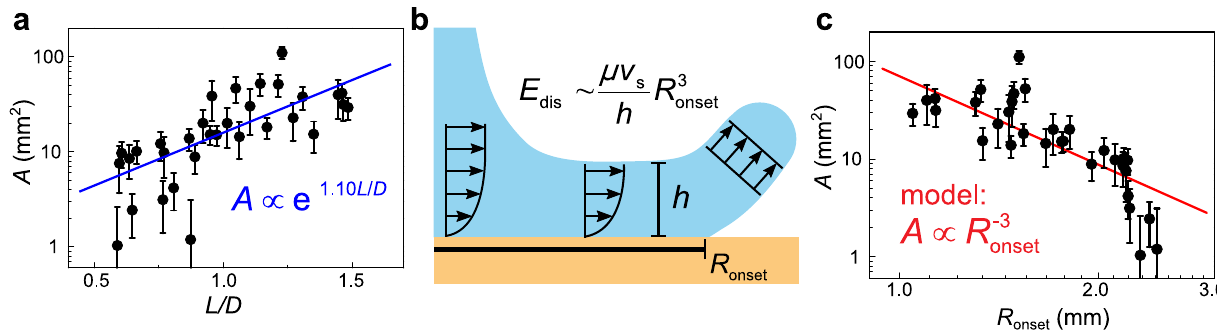
Fig. 4 The amount of splash explained by an energy dissipation model. a The total area of splatter stains, A , versus the dimensionless drop length, L/D , in log-linear scale. D is the diameter of an equivalent sphere with the same volume. The error bars represent standard deviations. We fi nd an exponential increase of splash amount with respect to the dimensionless length, A ∝ exp(1.10 L/D ). b Schematics showing the energy E dis dissipated in the spreading liquid sheet due to strong viscous shear before taking off. Here μ is the liquid viscosity, v s is the spreading velocity, h is the liquid fi lm thickness and R onset is the onset radius of splash. c Total area of splatter stains, A , versus the splash onset location, R onset , in log-log scale. The error bars represent standard deviations. The data agree with the power law, A / R (cid:3) 3 , predicted by the energy dissipation onset